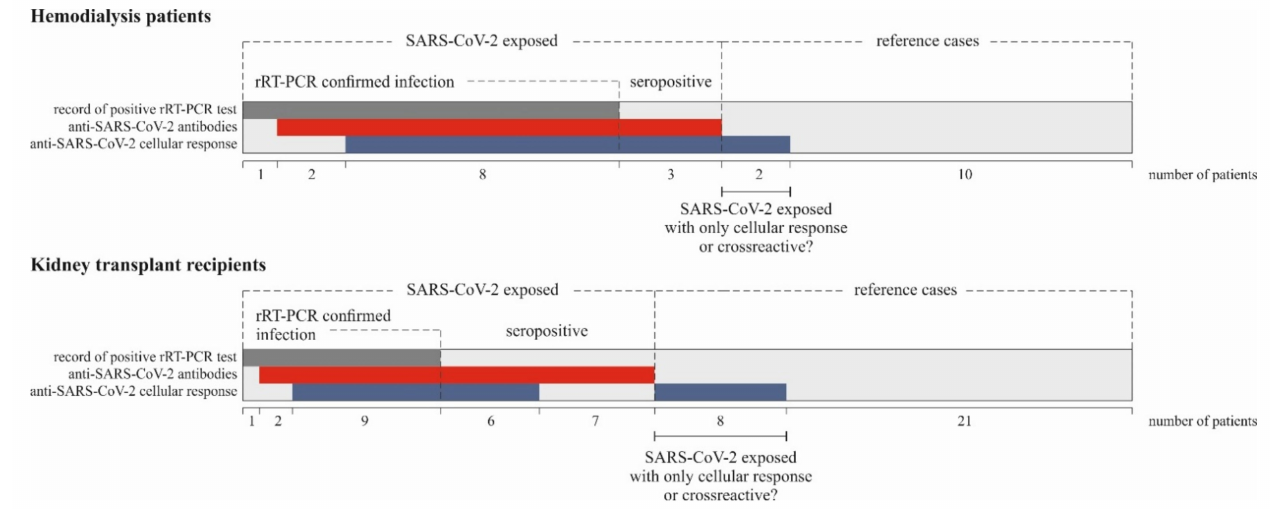
Figure 2. Observed type of SARS-CoV-2 specific response in KTR and HD patients included in the